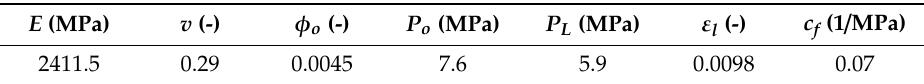
Table 4. Northern San Juan Basin [18,22].